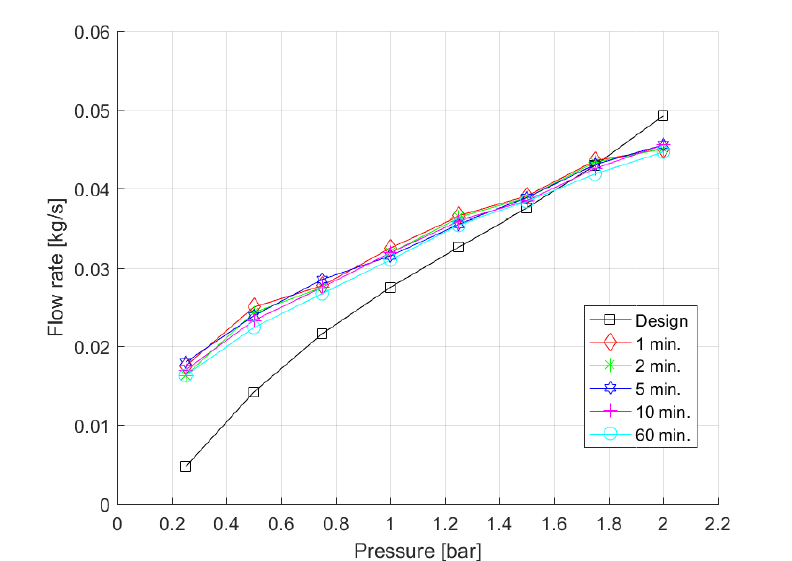
Figure 11. Measured and design flow rate sprayed from 3 nozzles with a sprayed angle of 90 ◦ and placed as depicted in Figure